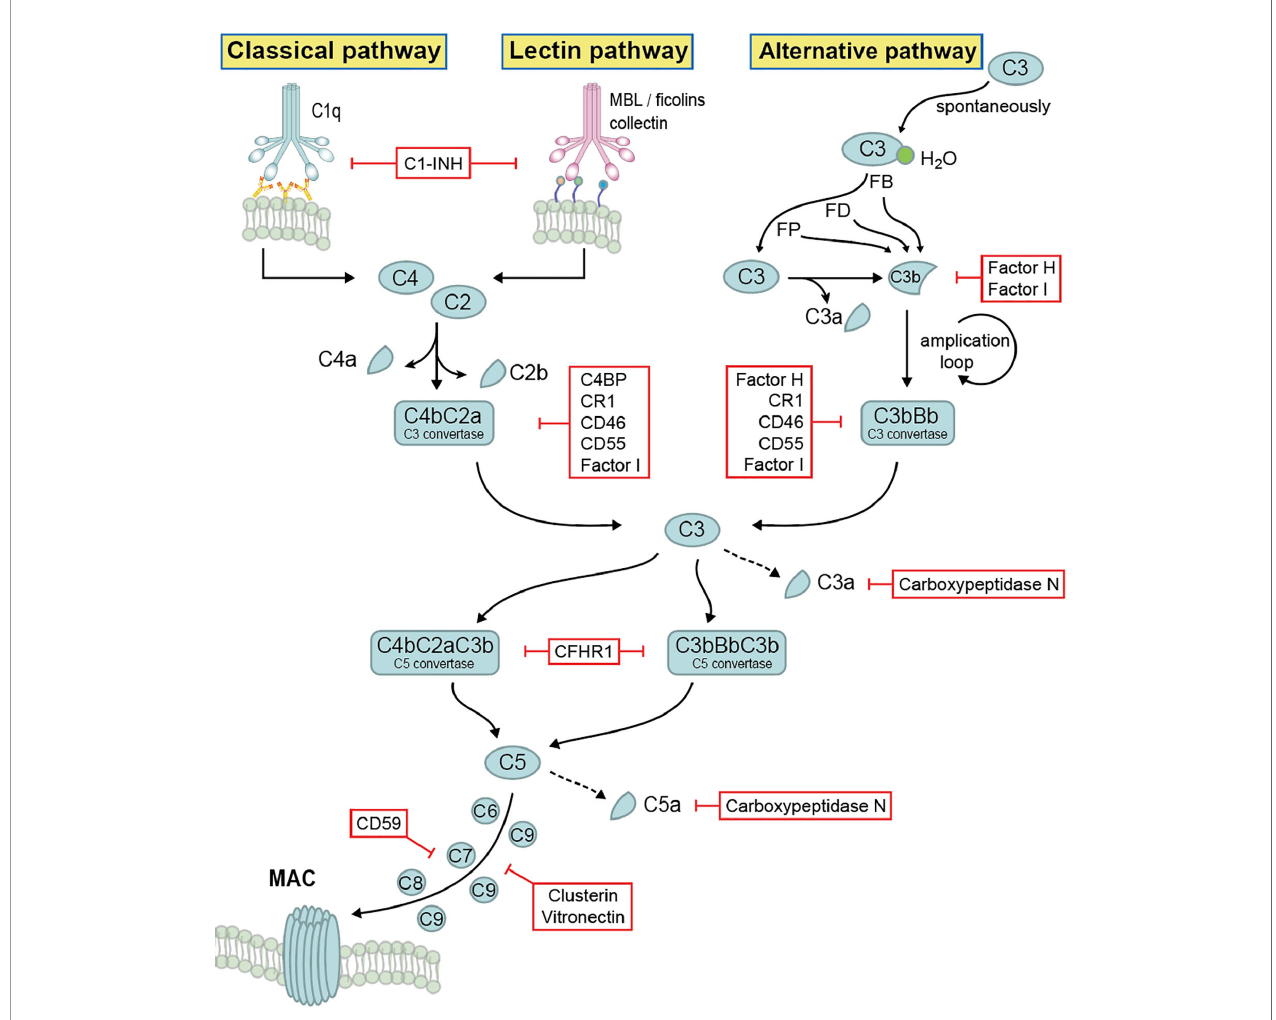
FIGURE 1 | Complement activation, effector function and regulation. Complement system is activated by three different pathways, then merged at the level of C3 cleavage, followed by C5 convertase formation and generation of terminal complement complex. Upon activation, different activation products are generated, which display multiple immune effector functions. The whole system is tightly self-controlled by different